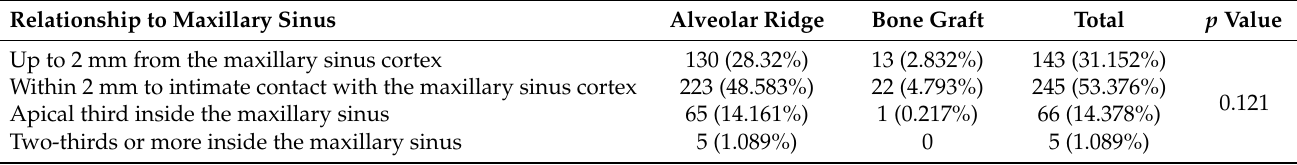
Table 3. Distribution of implants by bone-fixation tissue and implant-maxillary sinus